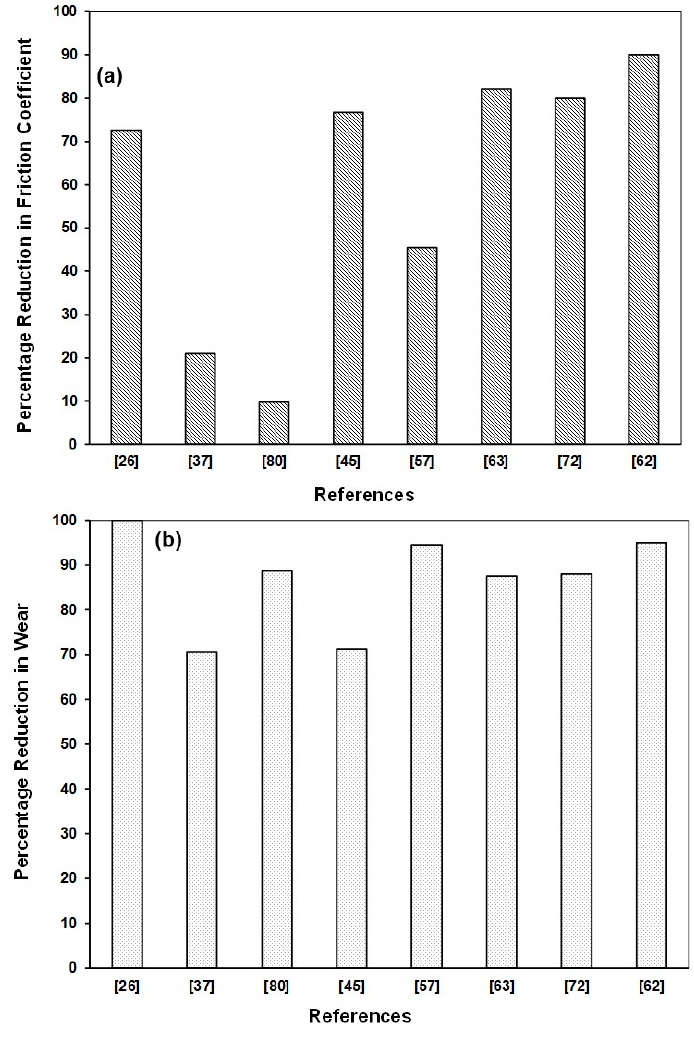
Figure 6. Comparison of effectiveness of LBE hybrid composite coatings in reducing ( a ) friction coefficient, ( b ) wear rate, under dry sliding